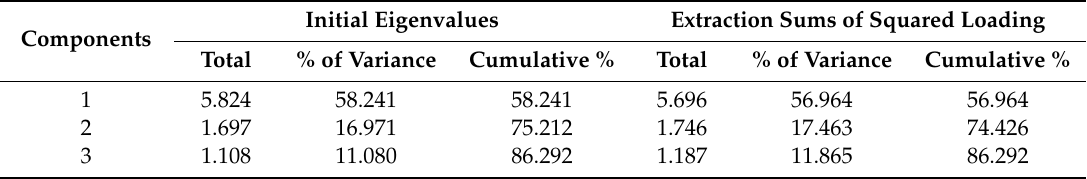
Table 8. Total variance